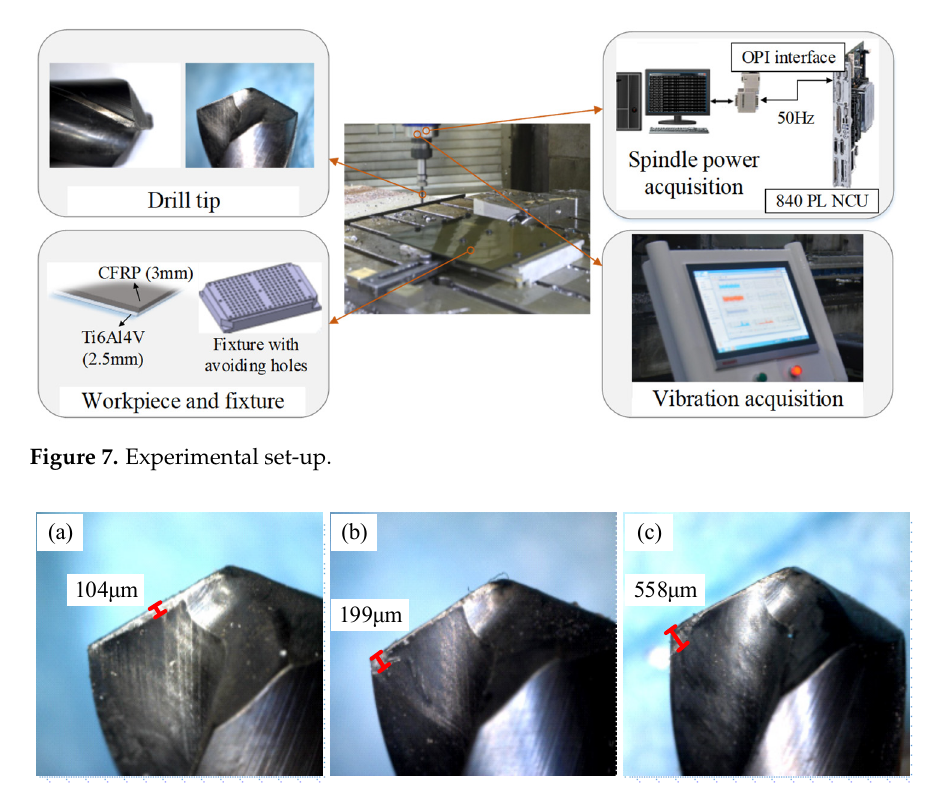
Figure 8. Morphology of main cutting edge: ( a ) after hole 48; ( b ) after hole 128; ( c ) after hole 208. Two of the same drills are used for the experiment with the same cutting parameters and experimental set-up. In addition, the curves of measured tool-wear values vs. drilling hole numbers for two drill bits are shown in Figure 9. The drilling tool-wear values both ascend with hole numbers.